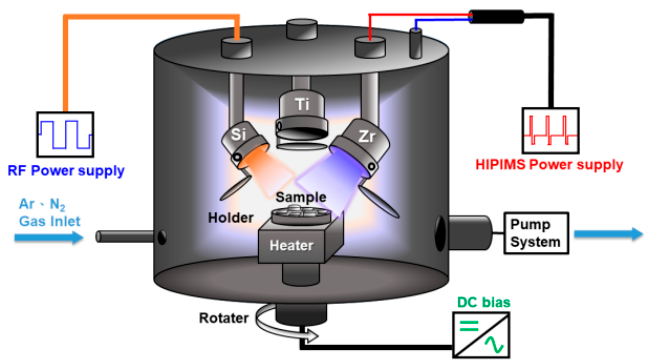
Figure 1. Schematic of the high-power impulse magnetron sputtering (HiPIMS) and radio-frequency magnetron sputtering (RFMS) co-sputtering equipment. Table 1. Sputtering parameters and thicknesses of Zr–Si–N films.